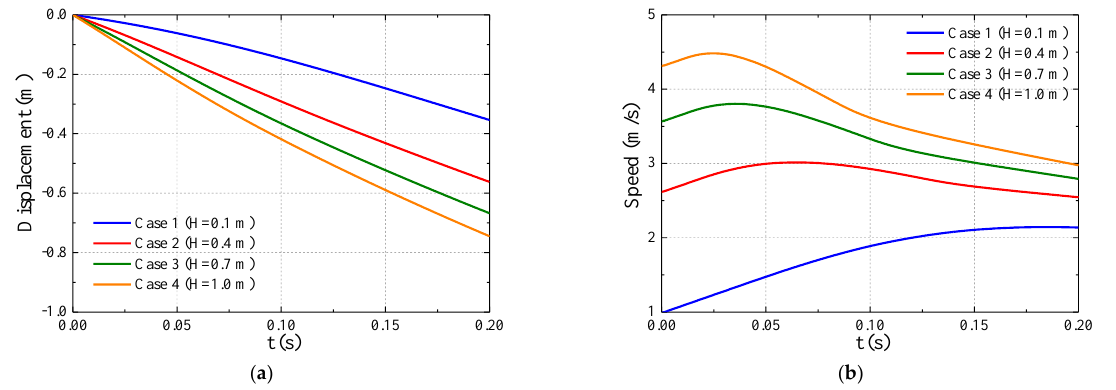
Figure 25. Vertical displacement and speed at different free falling heights: ( a ) displacement; ( b ) speed. Table 10. Comparison of speed information at different free falling heights.